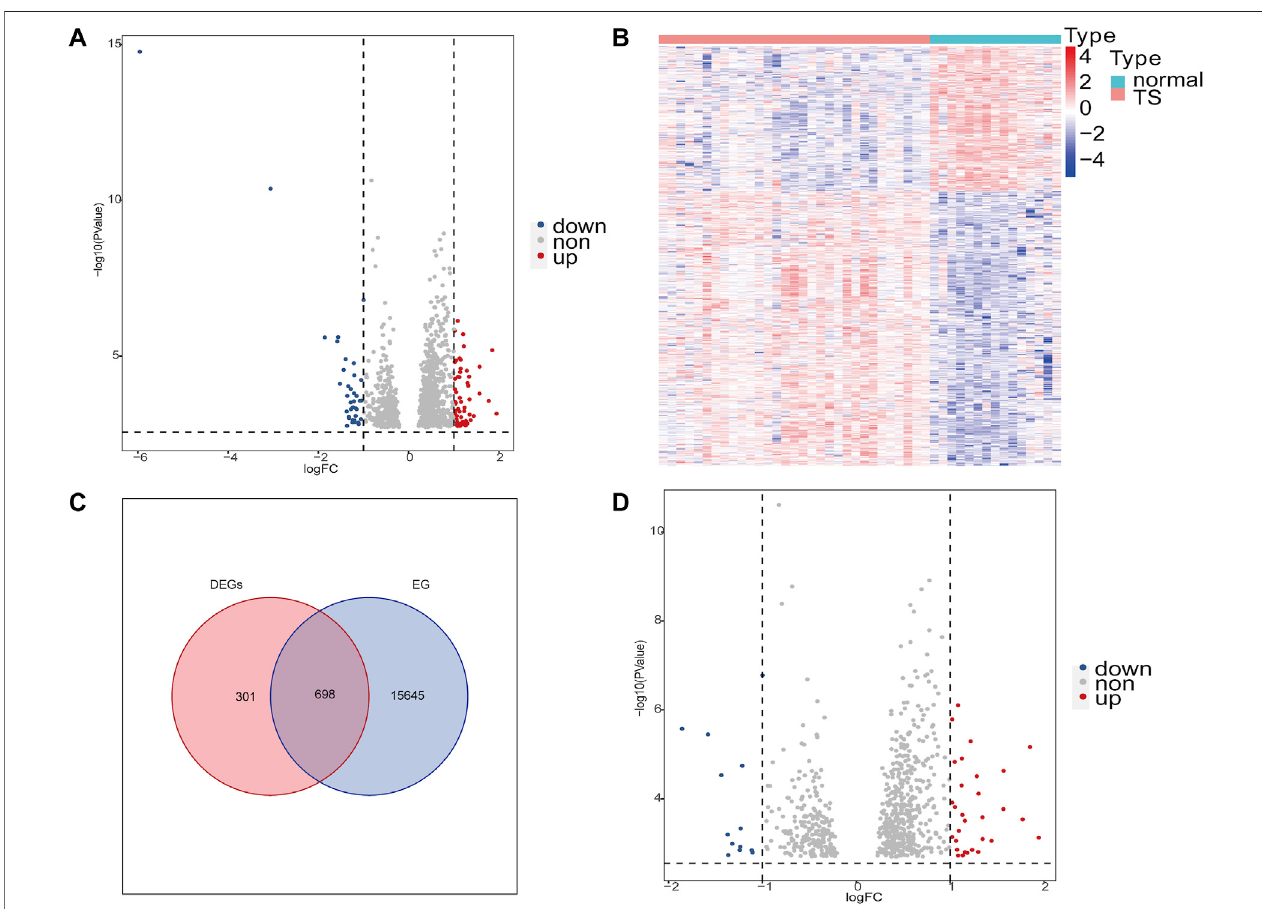
FIGURE 2 | Differentially expressed genes (DEGs) of TS and ear-related genes in TS (TSEs). (A,D) : Volcano plot of DEGs and TSEs. The abscissa is the log2FoldChange, and the ordinate is − log10 (adjusted p -value). Red indicates upregulated genes, blue indicates downregulated genes, and genes with no signi fi cant expressiondifferencesareshowningray. (B) :HeatmapoftheDEGsinTS.Highexpressionishighlightedinred;lowexpressionishighlightedinblue. (C) :Venndiagrams displaying the intersections of DEGs and ear-related genes (EGs). DEGs are red circles. Blue circles represent